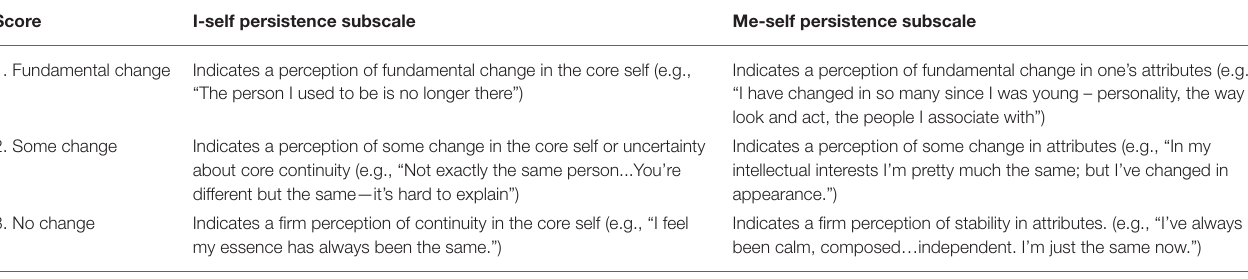
TABLE 2 | Summary of the coding scheme for the I-self and me-self questions of the self-persistence interview. Score